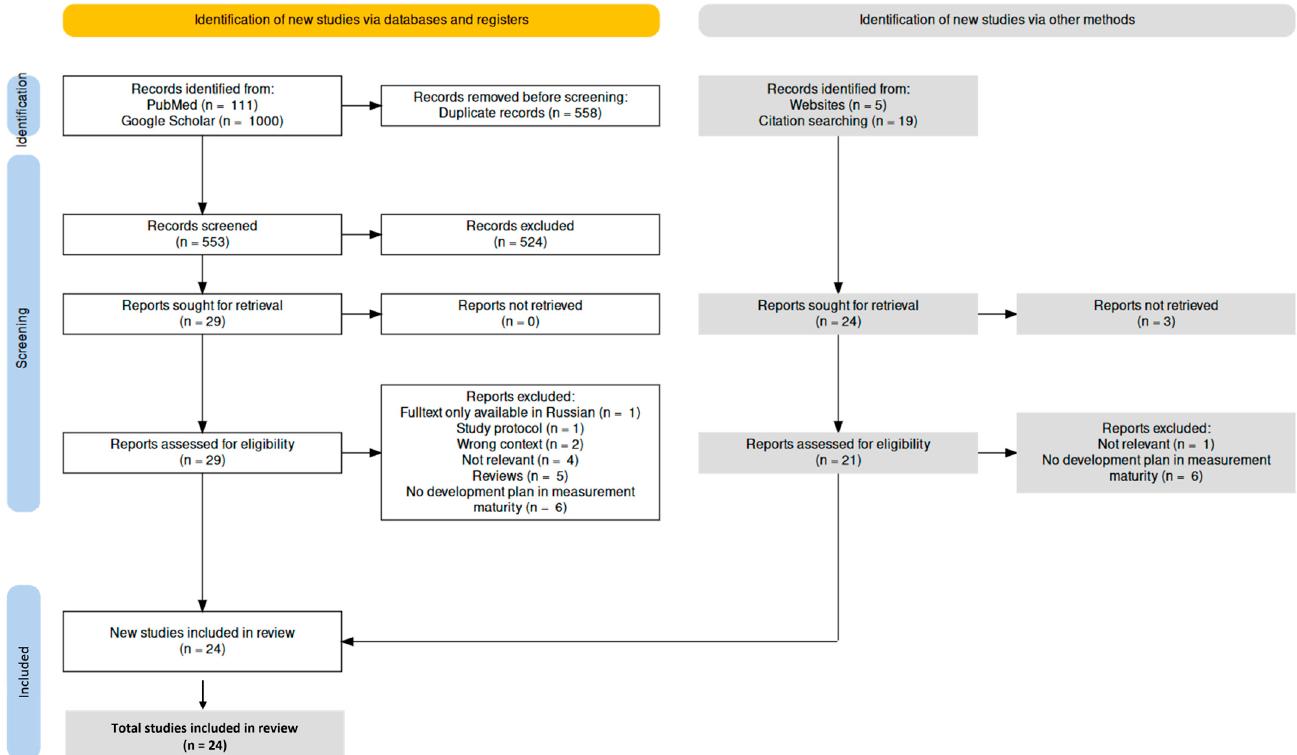
Figure 2. Preferred Reporting Items for Systematic Reviews and Meta-Analyses (PRISMA) flow diagram for articles identified, screened, and included in the review, made using the R ShinyApp.